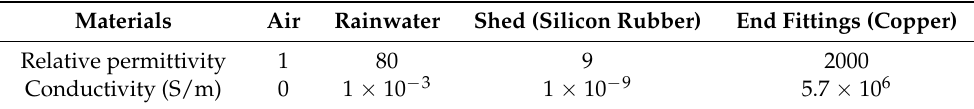
Table 3. Parameters of materials used in the